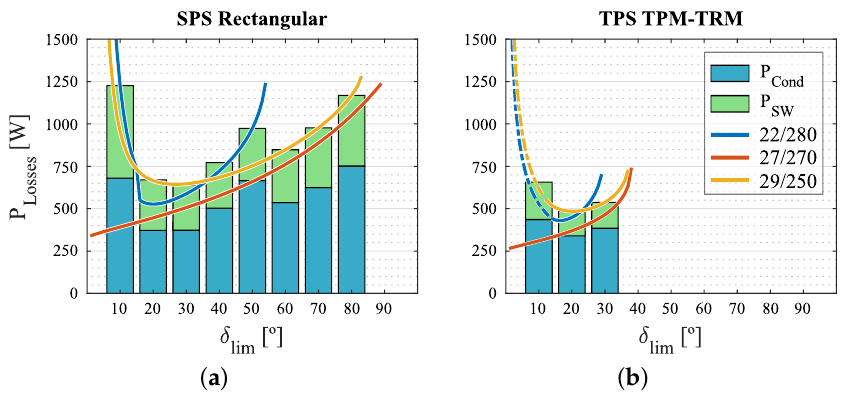
Figure 5. Power losses in the power devices of DAB converter for different operating DC voltages with: ( a ) SPS rectangular and ( b ) combined TPS-TPM and TPS-TRM modulations. The distribution of conduction and switching losses is depicted in the worst